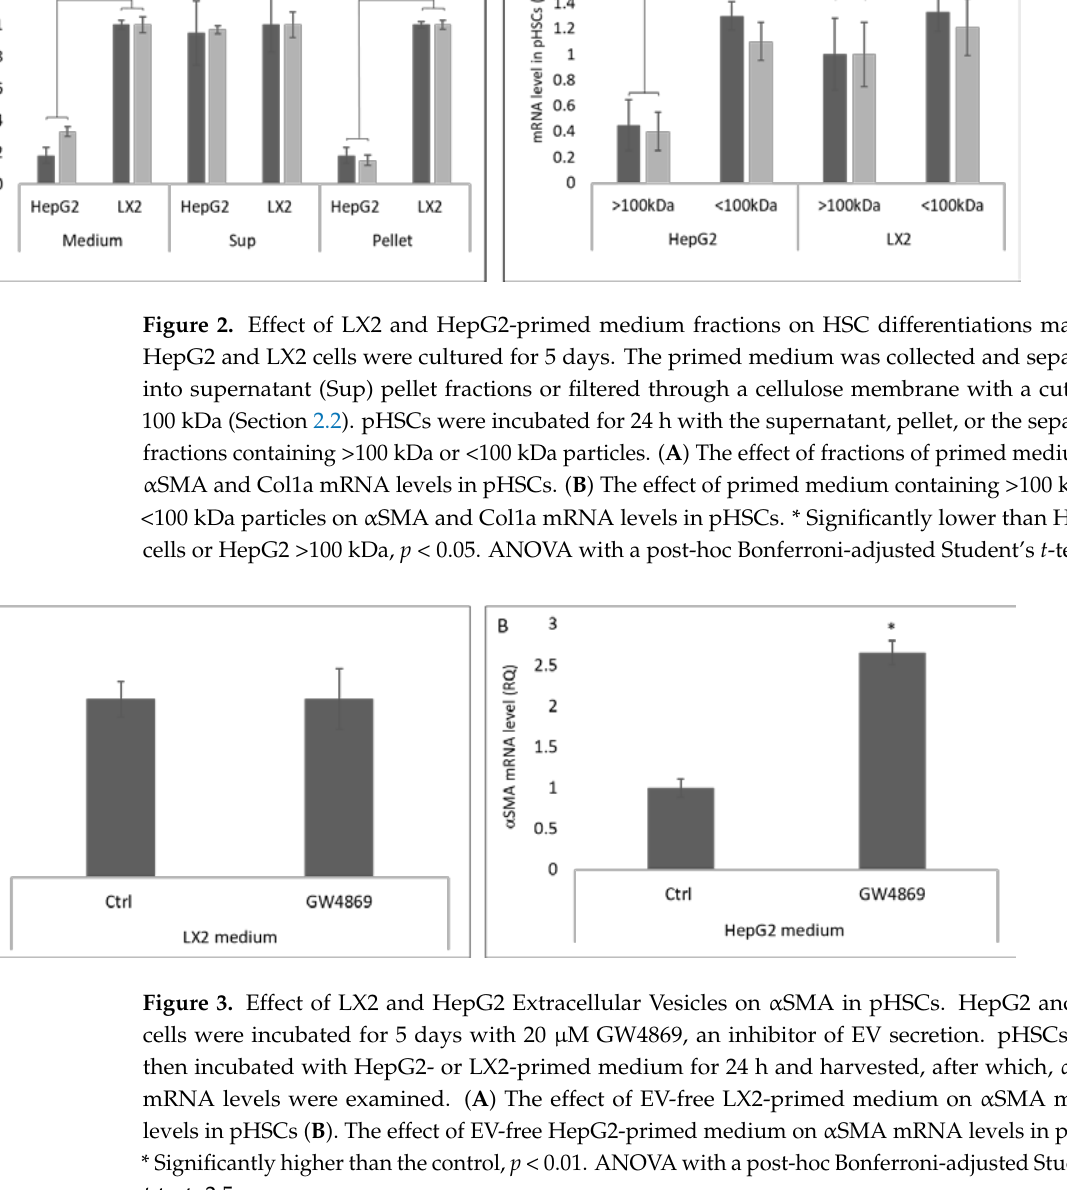
Figure 3. Effect of LX2 and HepG2 Extracellular Vesicles on αSMA in pHSCs. HepG2 and LX2 cells were incubated for 5 days with 20 µM GW4869, an inhibitor of EV secretion. pHSCs were then in- cubated with HepG2- or LX2-primed medium for 24 h and harvested, after which, αSMA mRNA levels were examined. ( A ) The effect of EV-free LX2- primed medium on αSMA mRNA levels in pHSCs ( B ). The effect of EV-free HepG2- primed medium on αSMA mRNA levels in pHSCs. * Sig- nificantly higher than the control, p < 0.01. ANOVA with a post-hoc Bonferroni-adjusted Student’s t -test. 2.5. Nanoparticle tracking analysis (NTA) of EVs isolated from both HepG2 and LX2 pel- lets. The average HepG2 and LX2 EVs yield was 2.56 × 10 −9 ±1.50 × 10 −8 particles for 1 L of medium. HepG2 and LX2 EVs measured a mean diameter of 95 ± 2.5 nm and an approxi- mate size range of 50 – 300 nm and 50 – 420 nm for HepG2 and LX2, respectively (Figure 4A,B). Transmission electron microscopy (TEM) analyses confirmed these diameters and showed that most of the particles were round-shaped (Figure 4C,D). Western blot analysis confirmed the presence of the EV-associated protein CD63 in both pellets (Figure 4E).